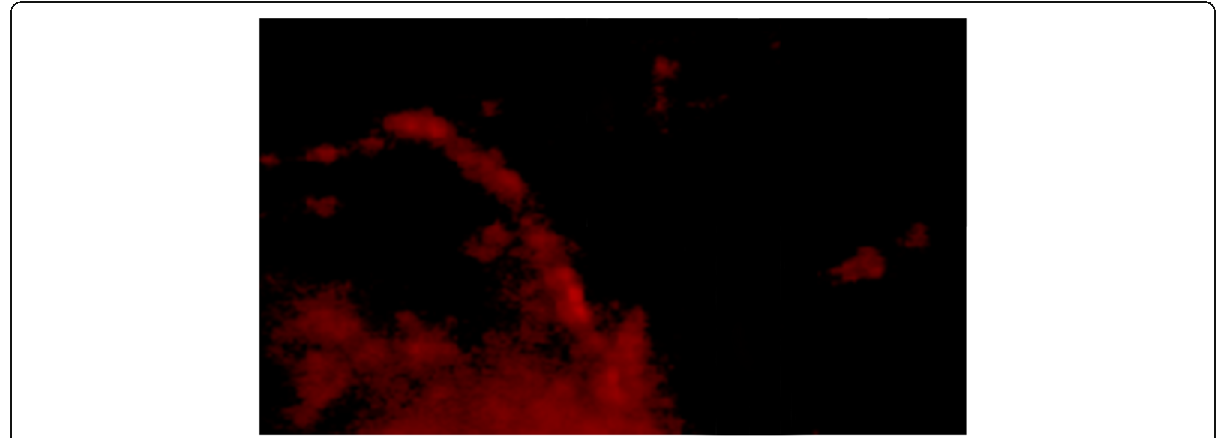
Fig. 1 Fluorescence microscopy of Nile-red stained F. oxysporum